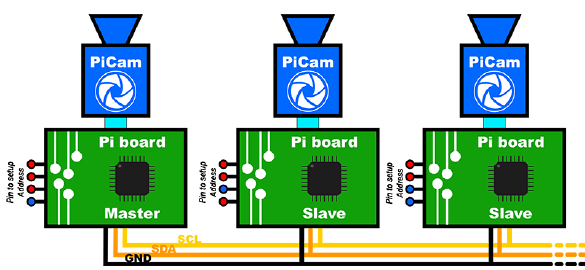
Figure 5. Final bench of several synchronized PiCams.